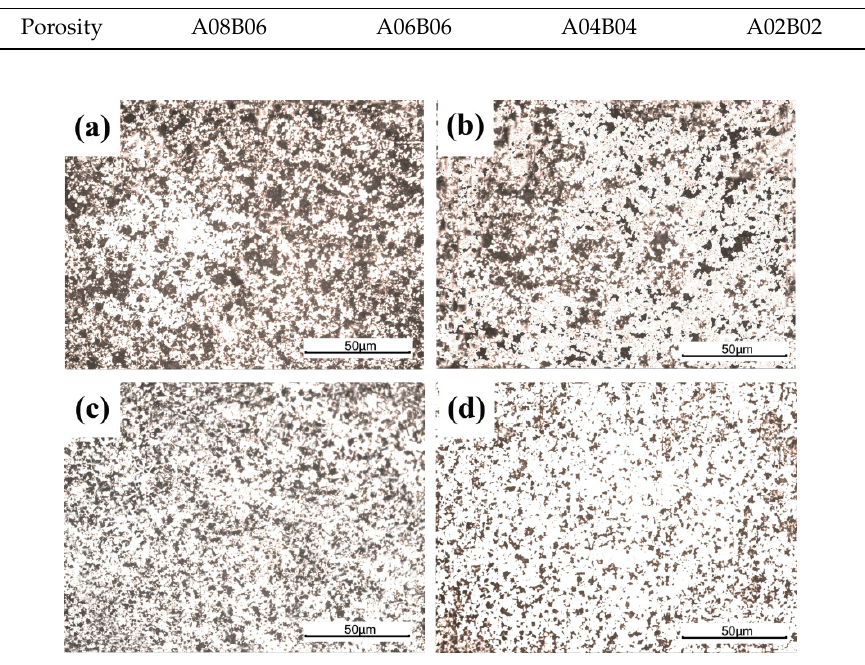
Figure 5. Light-optical microscopy of Ti(C,N)-based cermets: ( a ) 15Ni-1450 °C; ( b ) 20Ni-1450 °C; ( c ) 25Ni-1450 °C; ( d ) 30Ni-1450 °C.